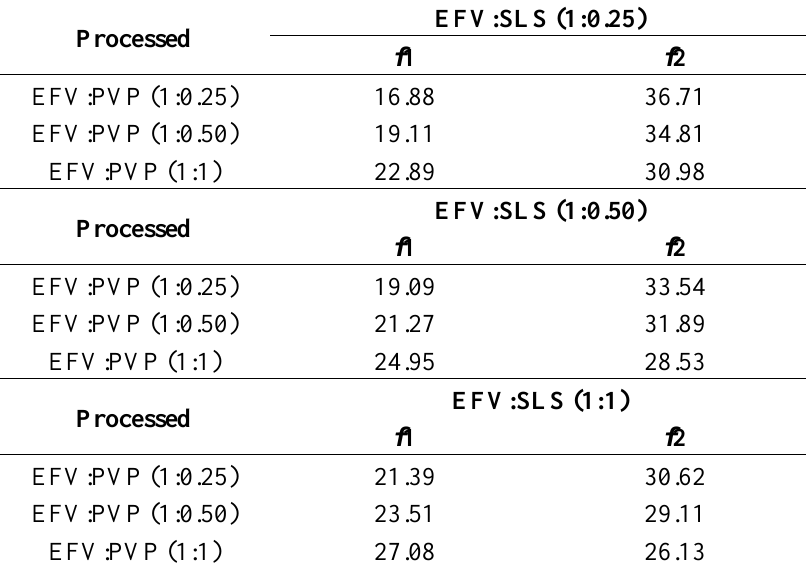
Table 6. Values of f 1 and f 2 found for EFV:PVP processed samples compared to EFV:SLS proportions.